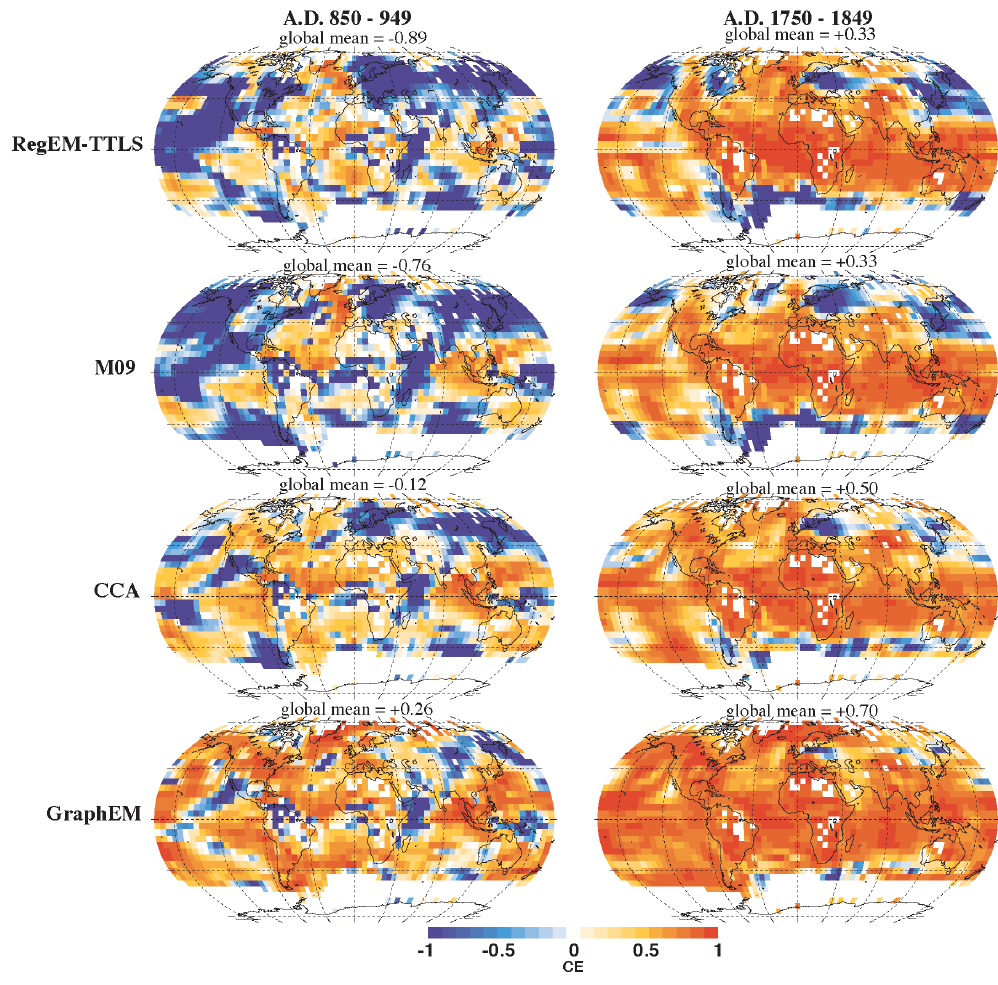
Fig. 10. Same as Fig. 9, but for the max SNR flat